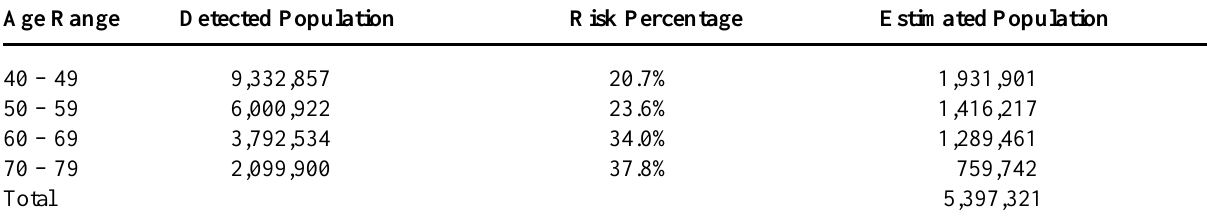
Table 4 – Estimated risk population subjected to medical treatment, according to age range in years.